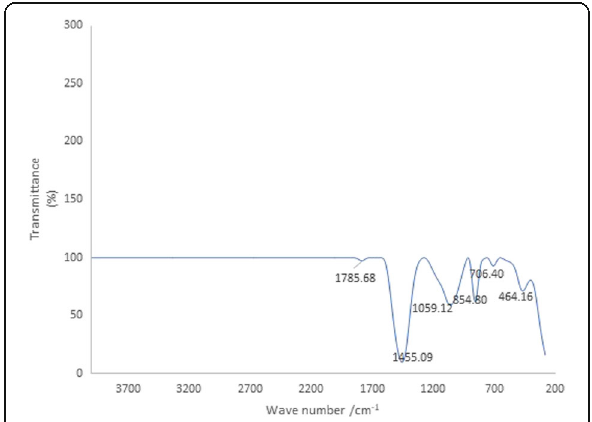
Fig. 4 Fourier transform infrared spectrometer spectrum of the main characteristic peaks of Au-CSCaCO 3 NPs. All marks correspond to the frequencies discussed in the text